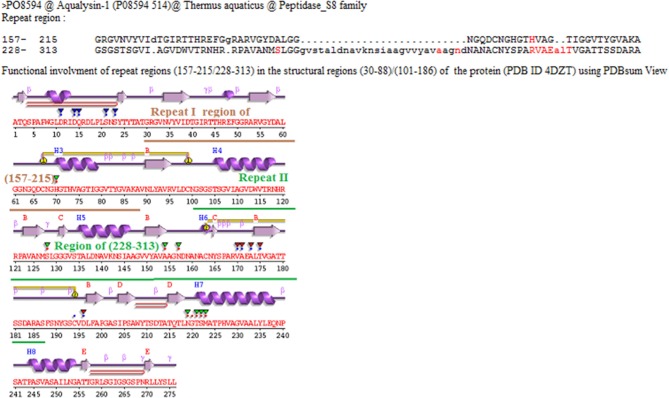
The functional residues of repeats (157–215/228–313) in the structural regions (30–88)/(101–186) (highlighted by red and green inverted triangles with red color dots) of Aqualysin-1 proteins are found out using PDBsum search.